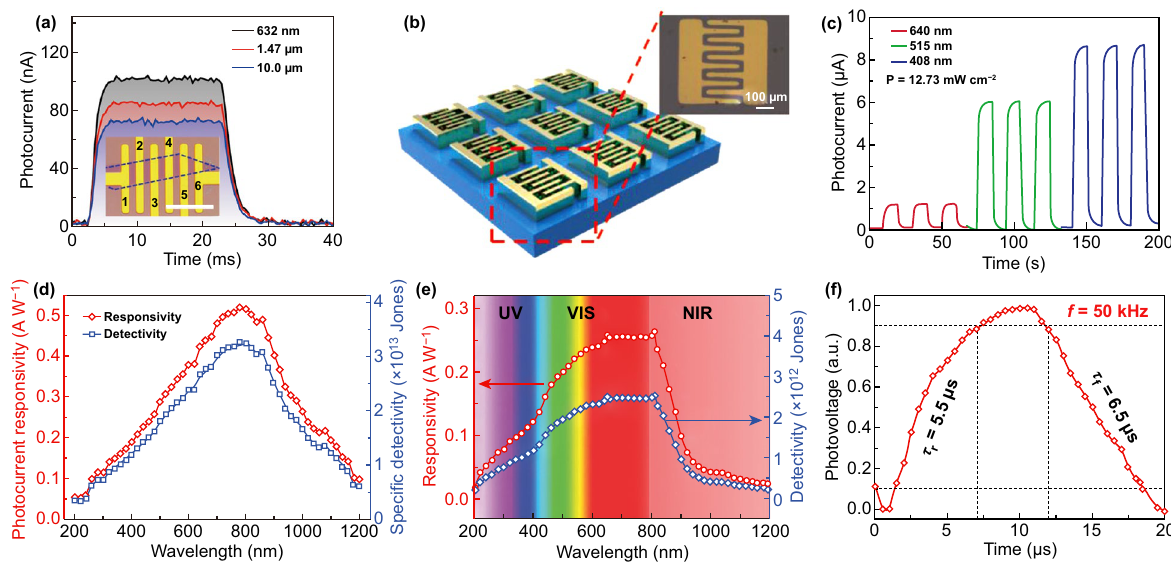
Fig. 10 Performance of PtSe 2 ‑based photodetectors. a Time resolved photoresponse of the bilayer PtSe 2 ‑based photodetectors; the inset is the microscopic image the device. Reproduced with permission [33]. Copyright 2018, Springer Nature. b Schematic structure and an optical microscopic image of the 2D PtSe 2 film‑based photodetector. c Time resolved photocurrent of the photodetector as a response to light on/off at wavelengths of 408 nm, 515 nm, and 640 nm. b , c Reproduced with permission [55]. Copyright 2018, John Wiley and Sons. d Photocurrent responsivity and specific detectivity of the PtSe 2 film‑based photodetector as functions of the wave length of the incident light. Reproduced with permission [116]. Copyright 2018, Royal Society of Chemistry. e Responsivity and detectivity of the PtSe 2 /GaAs heterojunction as a function of wavelength. f A single normalized cycle measured at 50 kHz for estimating both response time ( τ r ) and recovery time ( τ f ). e–f Reproduced with permission [121]. Copyright 2018, John Wiley and